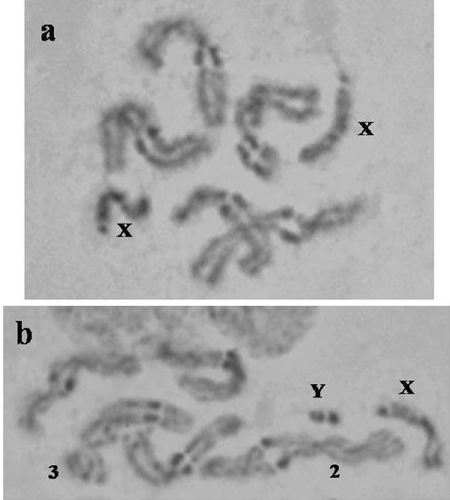
Figure 1. Mitotic karyotype of Ceratitis fasciventris . ( a ) Female karyotype. The X chromosomes are indicated. ( b ) Male karyotype. The autosomes 2 and 3 and the X and Y chromosomes are indicated. Chromosomes were stained with Giemsa.